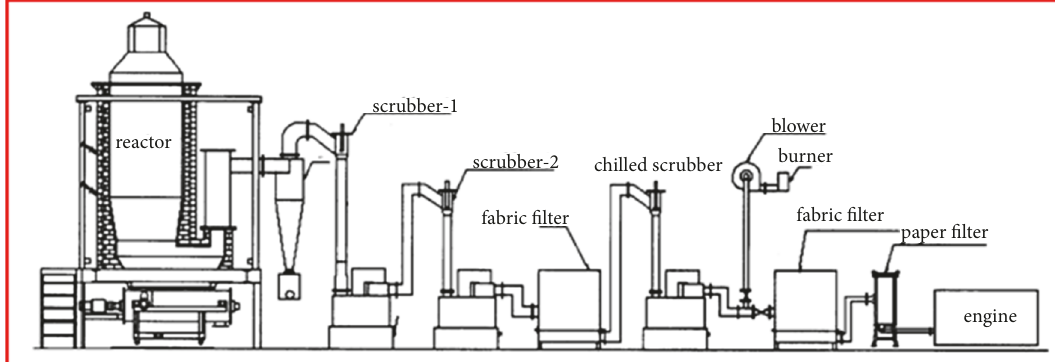
Figure 5: Schematic diagram of biomass gasification plant [3].